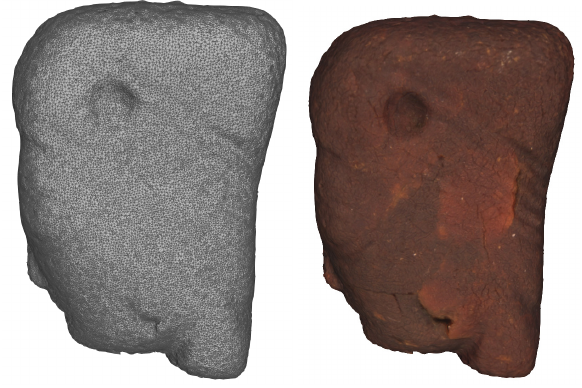
Figure 5. Ancient amber figurine. a) TIN-model; b) photo- realistic textured